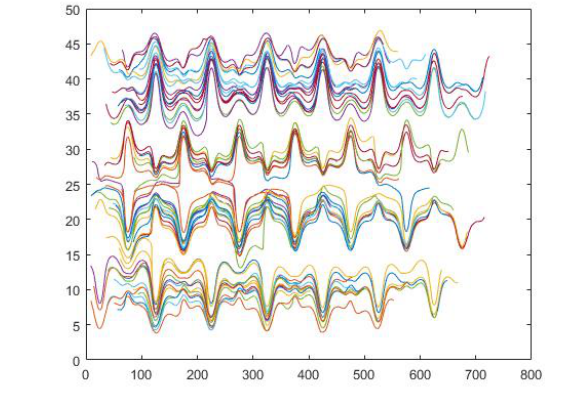
Fig. 15. Geometry A50, two different seedings, Y-coordinate position in relation to X-coordinate